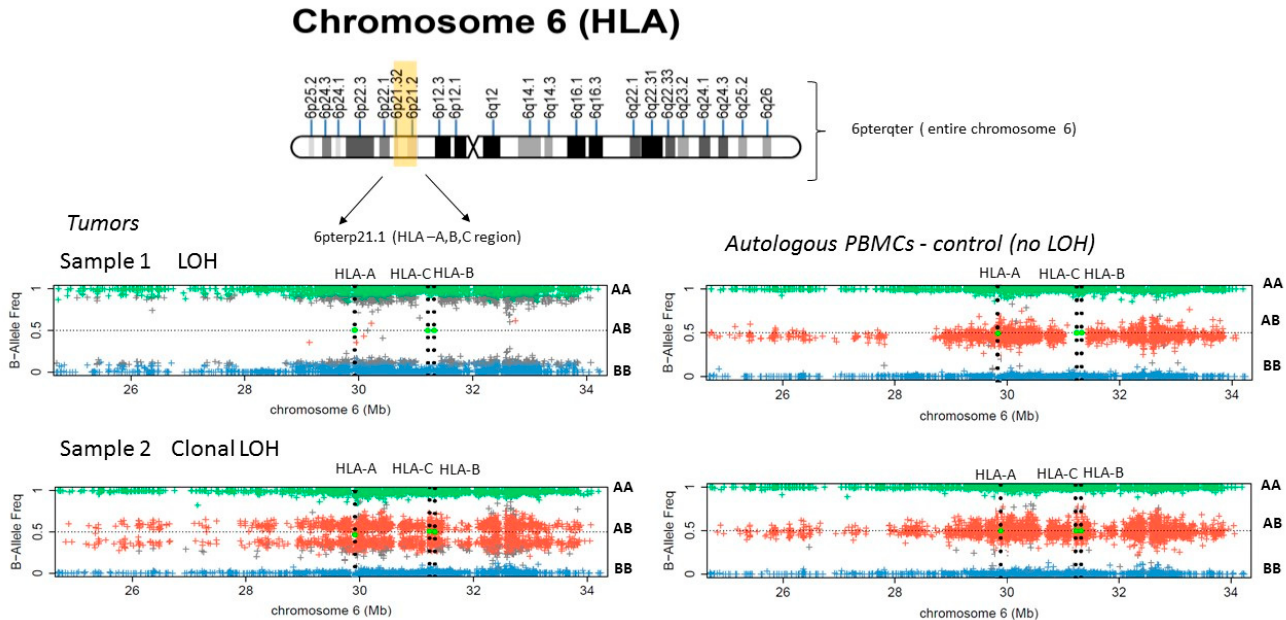
Figure 5. SNPs array analysis of LOH in bladder tumors with alterations in HLA-I expression. Sample 1 picture depicts LOH involving entire HLA-A , B , C genetic region (6p21) (deletion 6pter21.1, as demonstrated on the chromosome 6 map) in the tumor sample, as compared to a normal pattern in autologous PBMCs. Sample 2 plot depicts a clonal LOH of the entire chromosome 6 (6pterqter) in the tumor, and affects only a proportion of tumor cells (two red bands of SNPs). AA, AB, BB-represent the different genotypes corresponding to homozygous (AA or BB) and heterozygous (AB) versions.